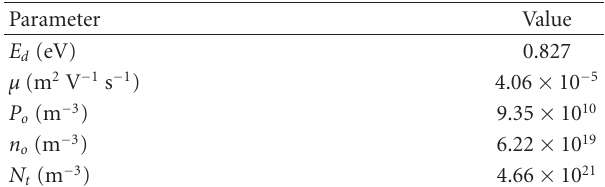
Figure 6: Semilogarithmic plot of ln J versus 1/T at temperature range of 350–440 K and applied voltage of 0.9 V. Table 3: Electrical parameters analyzed from J-V characteristics at 320K.